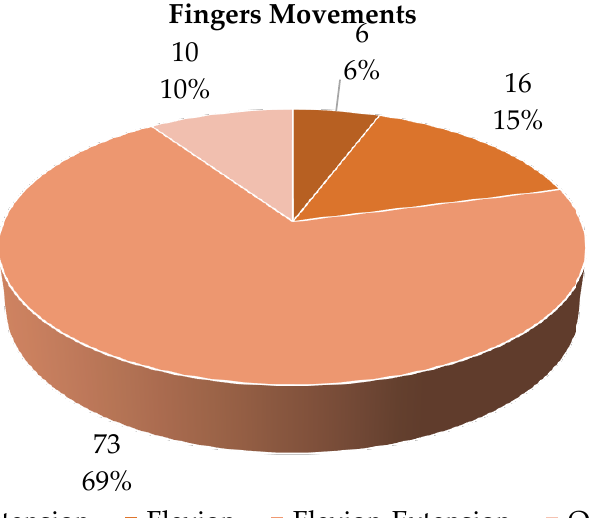
Figure 29. Fingers movement actuated by the soft glove. the class are identified as follows: extension refers to cases in which only extension is actuated; flexion refers to cases in which only flexion is actuated; flexion–extension: refers to cases in which both Extension and flexion are actuated (but non necessarily both